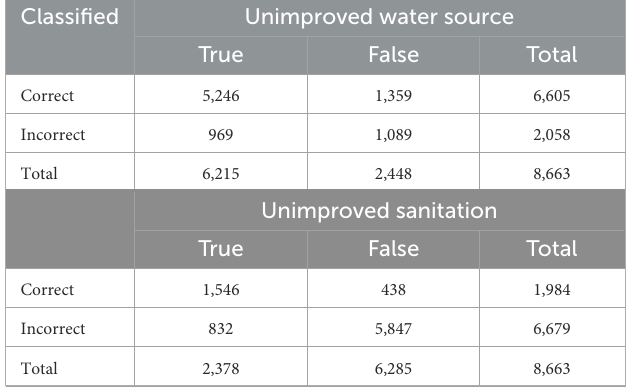
TABLE 2 Specificity analysis of unimproved water source and sanitation facilities.